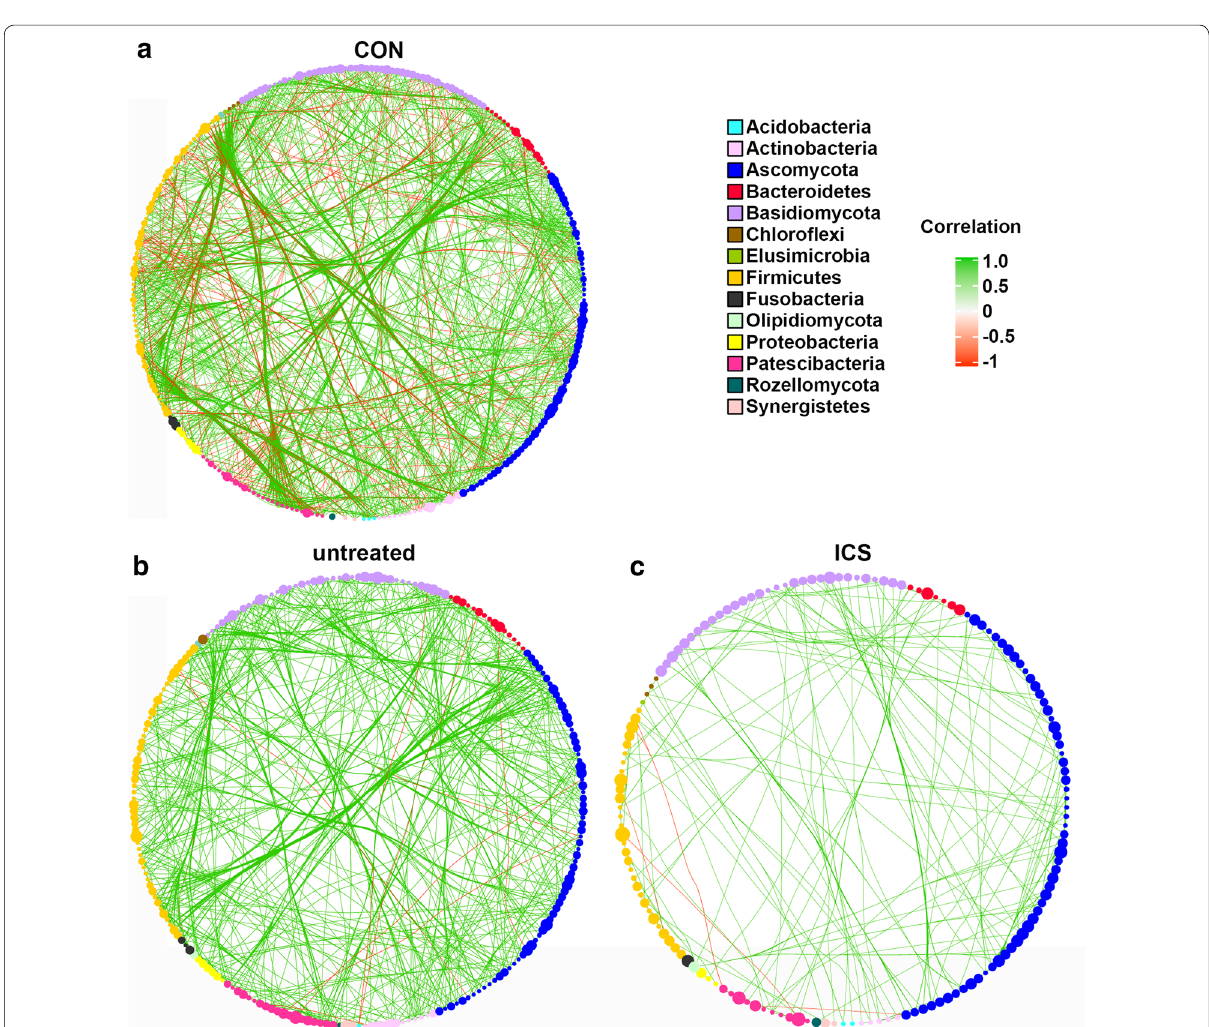
Fig. 6 Fungal-bacterial network with top 150 genera. Networks in CON ( a ), untreated asthma ( b ) and ICS asthma ( c ) group were performed by using Cytoscape. Each circle (node) represents a microbial genus, its colour represents the bacterial or fungal phylum it belongs to and its size represents the number of direct edges that it has. The edge colour indicates the magnitude of the distance correlation; green indicates positive correlation and red indicates negative correlation (determined using spearman test). Only significant correlations (p value < 0.05 after false discovery rate correction) are